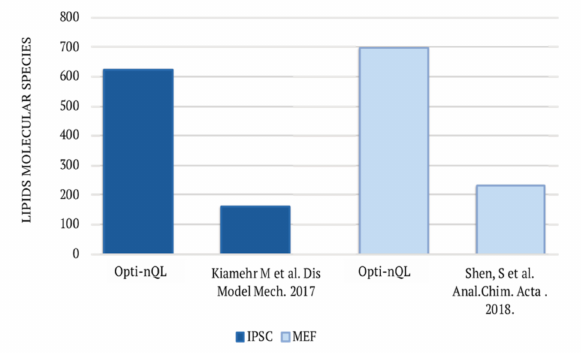
Figure 3. Comparison of Opti-nQL method with already published lipidomics analysis performed on the same cell lines. Opti-nQL leads to a higher number of identified